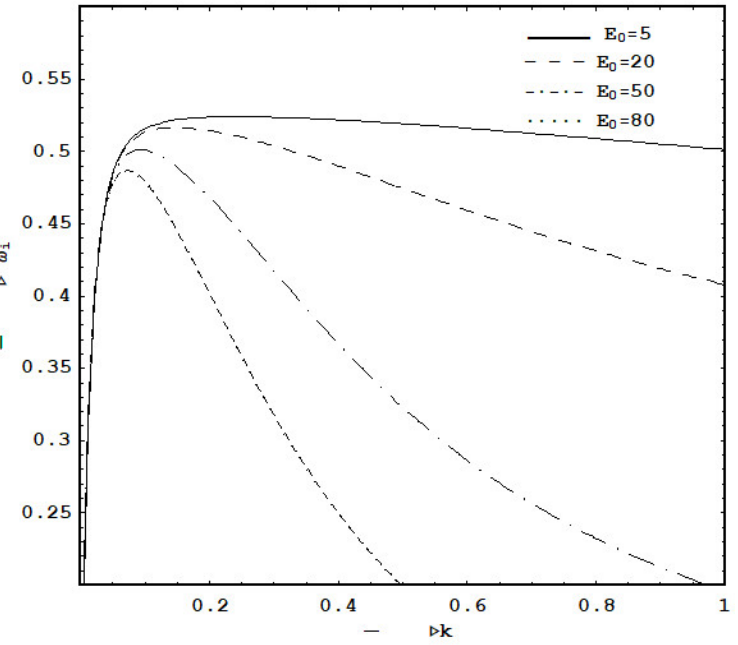
Figure 16. Variation of the growth rate ω i with the wavenumber k for different values of the axial electric field E 0 .